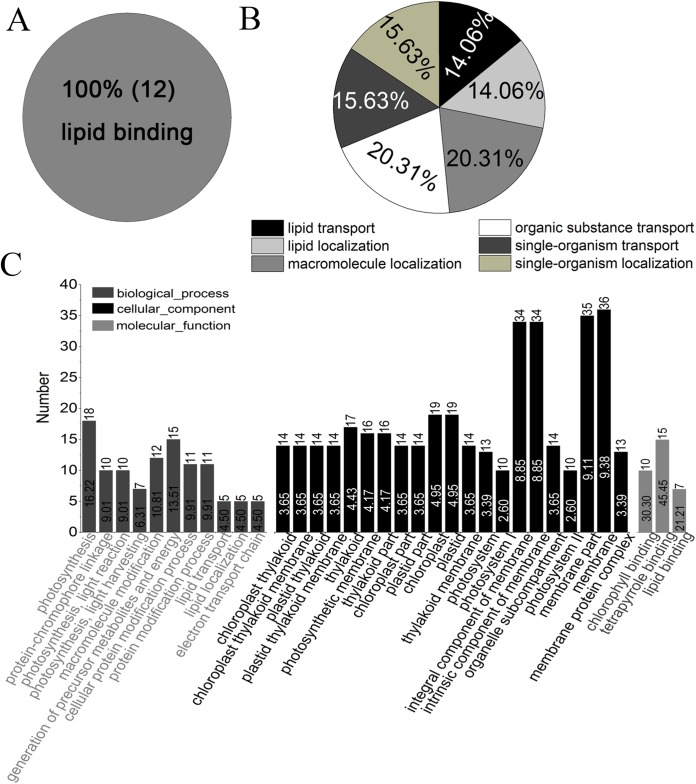
GO classification of DAPs of Group 1 to 4 from four flower development stages in YM18 and ZK001 based on GO enrichment.(A) Molecular function of Group 1; (B) biological process of Group 1; (C) biological process, cellular component, and molecular function of Group 2. No protein was enriched in Group 3 or Group 4 basing on GO enrichment. (0.667 < FC < 1.5, corrected P-value < 0.01, PSMs ≥ 2).